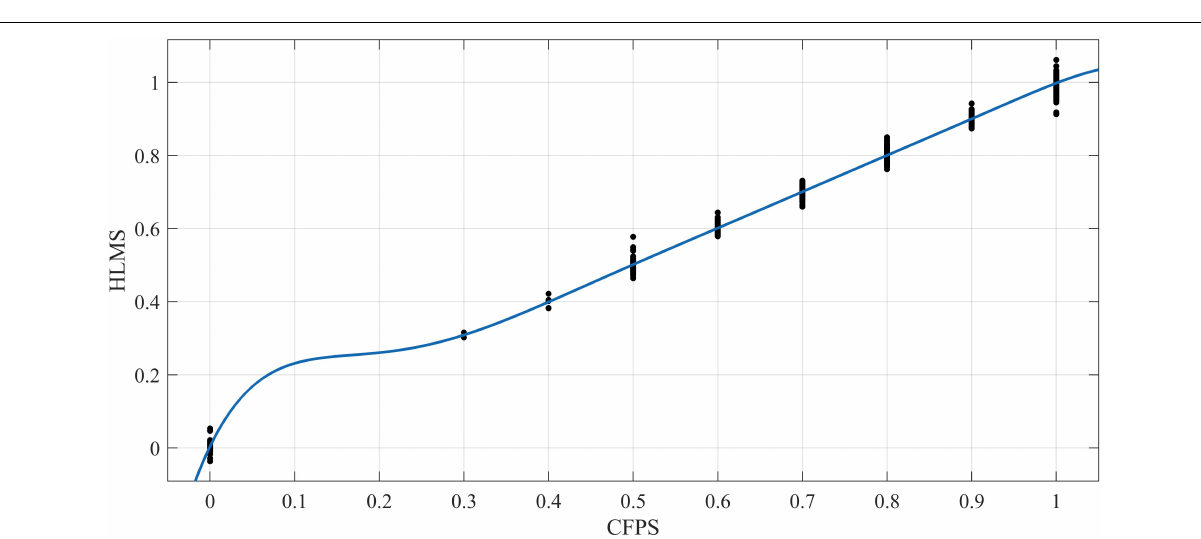
FIGURE 1 | The figure fits the Fourier curves of CFPS data and MLR data. The software reports that the sum of squares for error (SSE) is 32.55, the R-square coefficient is 0.448, and the root mean square error (RMSE) is 0.075. The analysis of the three fitting data shows that the fitting effect of MLR is not good, because SSE is too large and the R-square coefficient is less than 0.5.